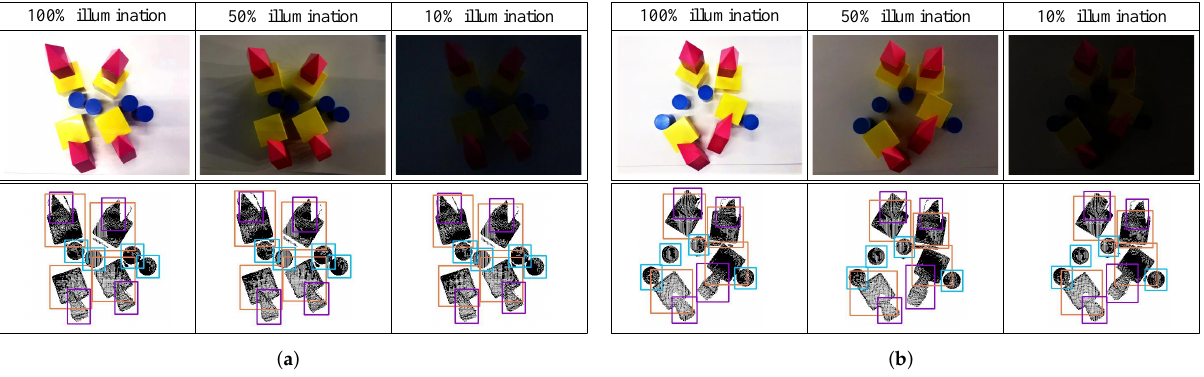
Figure 9. Stacked Object Classification using the proposed method. The red box represents the cube class, the purple box represents the pyramid class and the blue box represents the cylinder class.